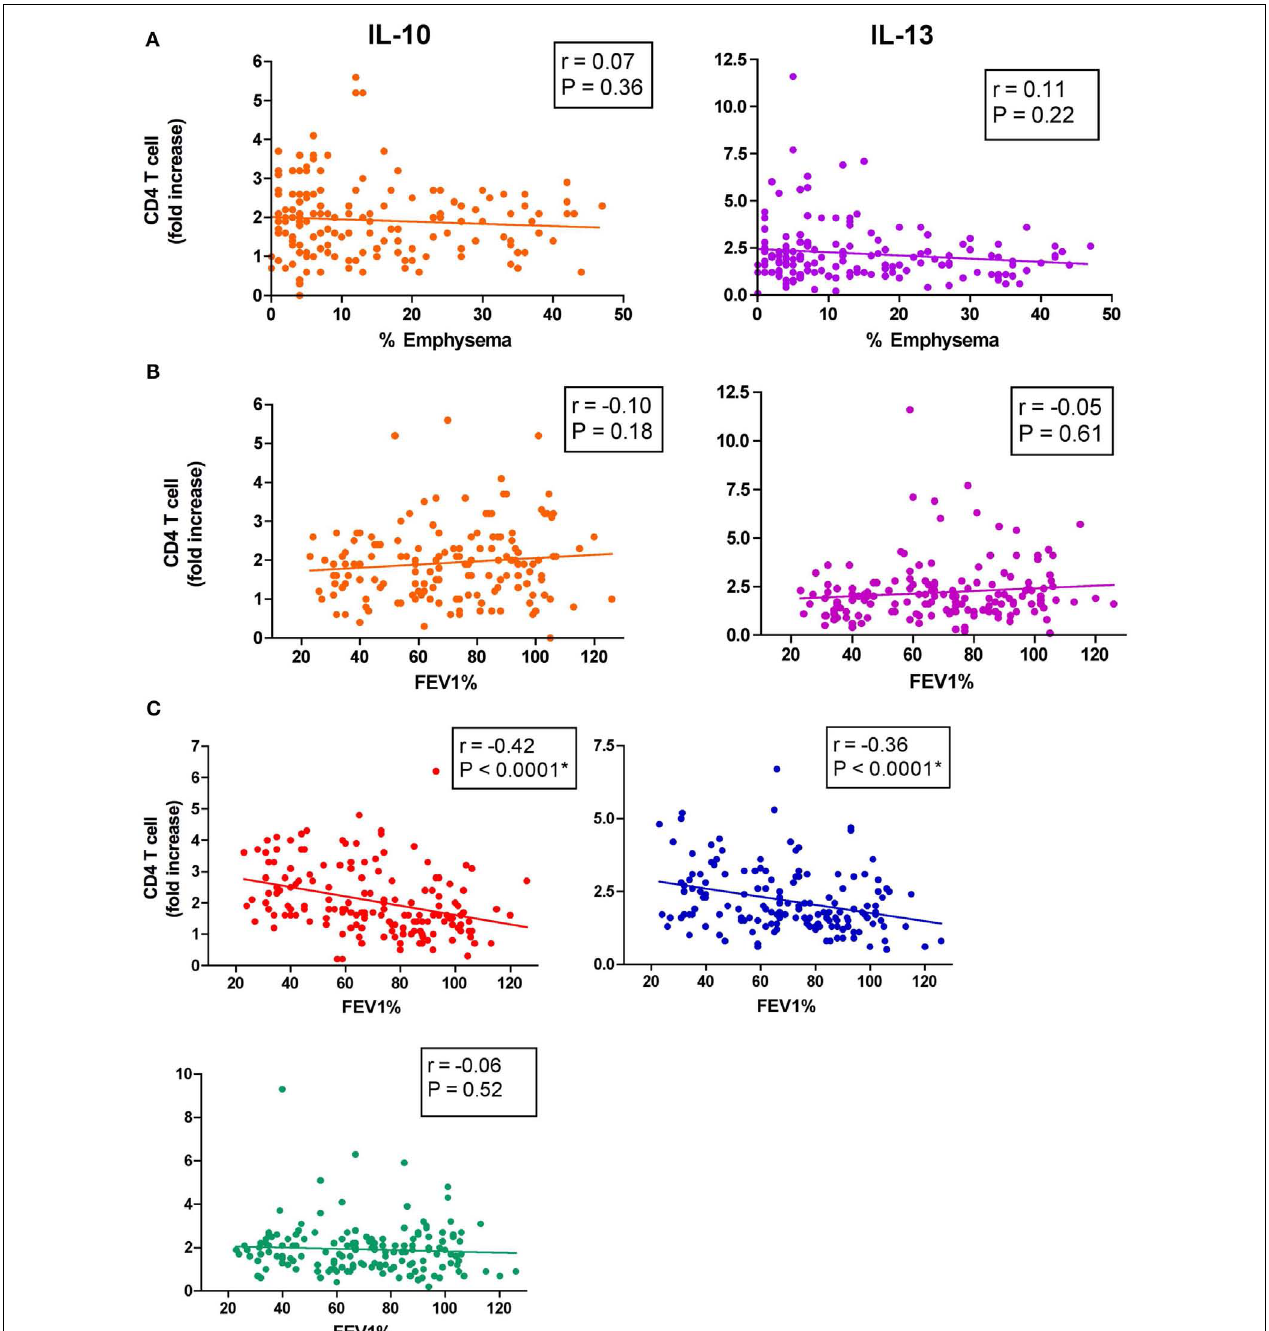
fragment compared to nil stimulation as described in Figure 1 legend. (C) forced expiratory volume in 1s % predicted (FEV 1 %) are plotted against the fold increase in production of IFN- γ , IL-6, and IL-17 by freshly isolated peripheral blood CD4 + T cells ( n = 156) in response to elastin fragments (EFs) compared to nil stimulation as described